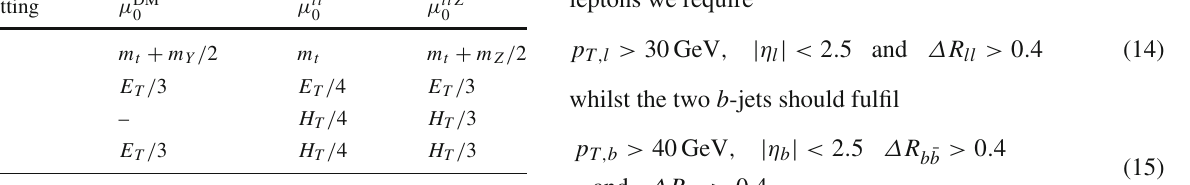
Table 1 Summary of central scale settings for the three considered processes Scale